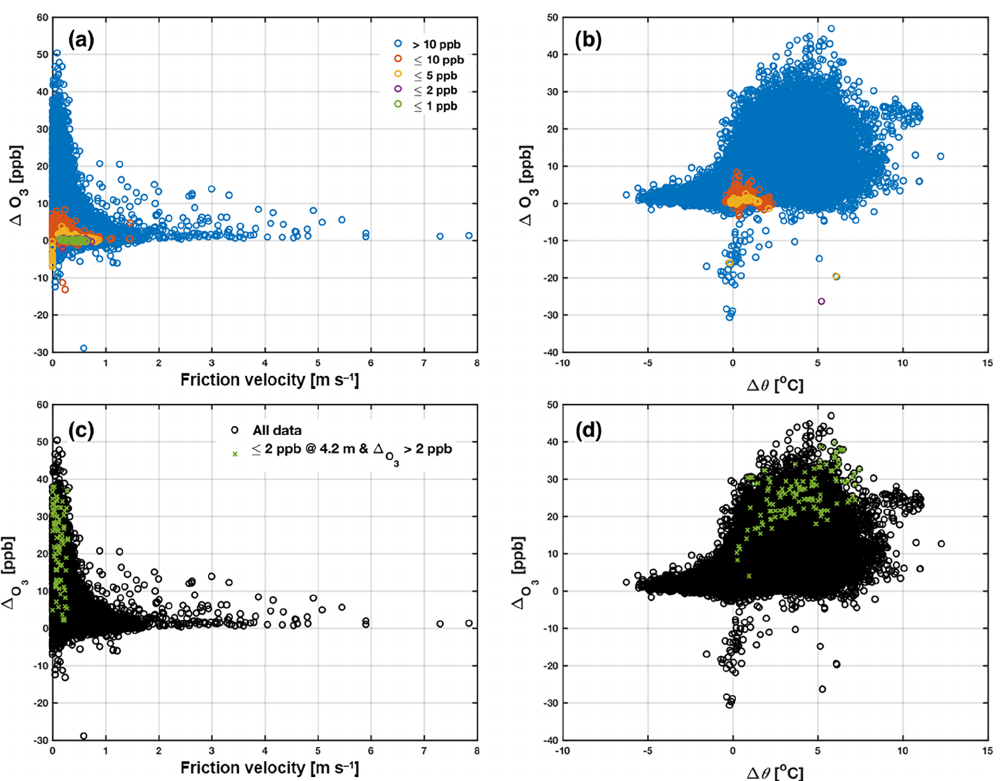
Figure 8. Ozone concentration difference between 67.2 and 4.2m measurement levels vs. (a, c) friction velocity determined at 23.3m and (b, d) potential temperature difference between 67.2 and 4.2m measurement levels. The colour codes in (a, b) represent concentration drops below 10, 5, 2, and 1ppb from the ozone measurement at 67.2m. The green crosses in (c, d) mark the data points fulfilling the conditions that the ozone concentration at 4.2m is smaller than 2ppb, while the difference in the ozone concentration between 67.2 and 4.2m is larger than